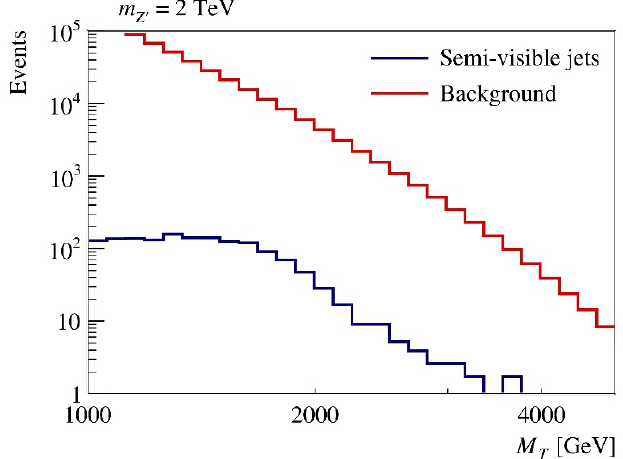
Figure 6 . Di(cid:11)erential cross section with respect to the transverse jet mass M T for semi-visible jets obtained from the dark showers produced by the decays of a Z the SM backgrounds simulated in ref.